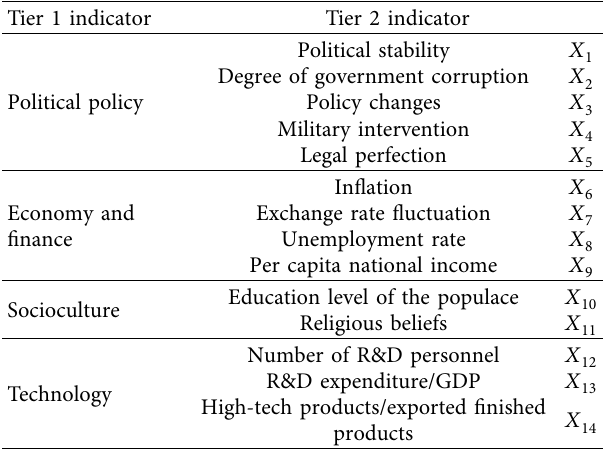
Table 1: System of risk